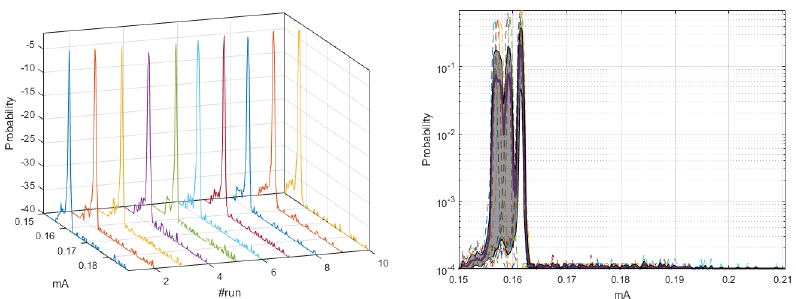
Figure A4. Plots of pdf for DigiMesh network at 9600 bauds: ( Left ) M-mode; and ( Right ) histograms of each realization (discontinuous), and bootstrap CI (gray shading). From top to bottom: Coordinator Node and Nodes 1–4.